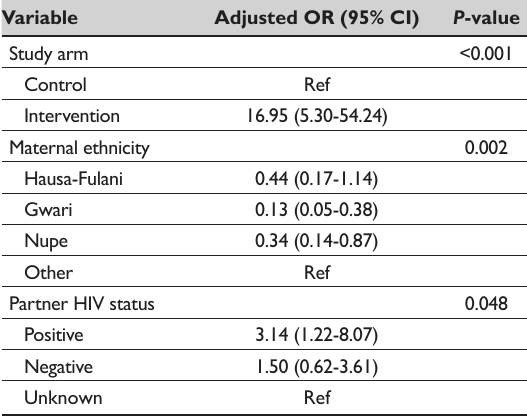
Table 2: Predictors of maternal adherence